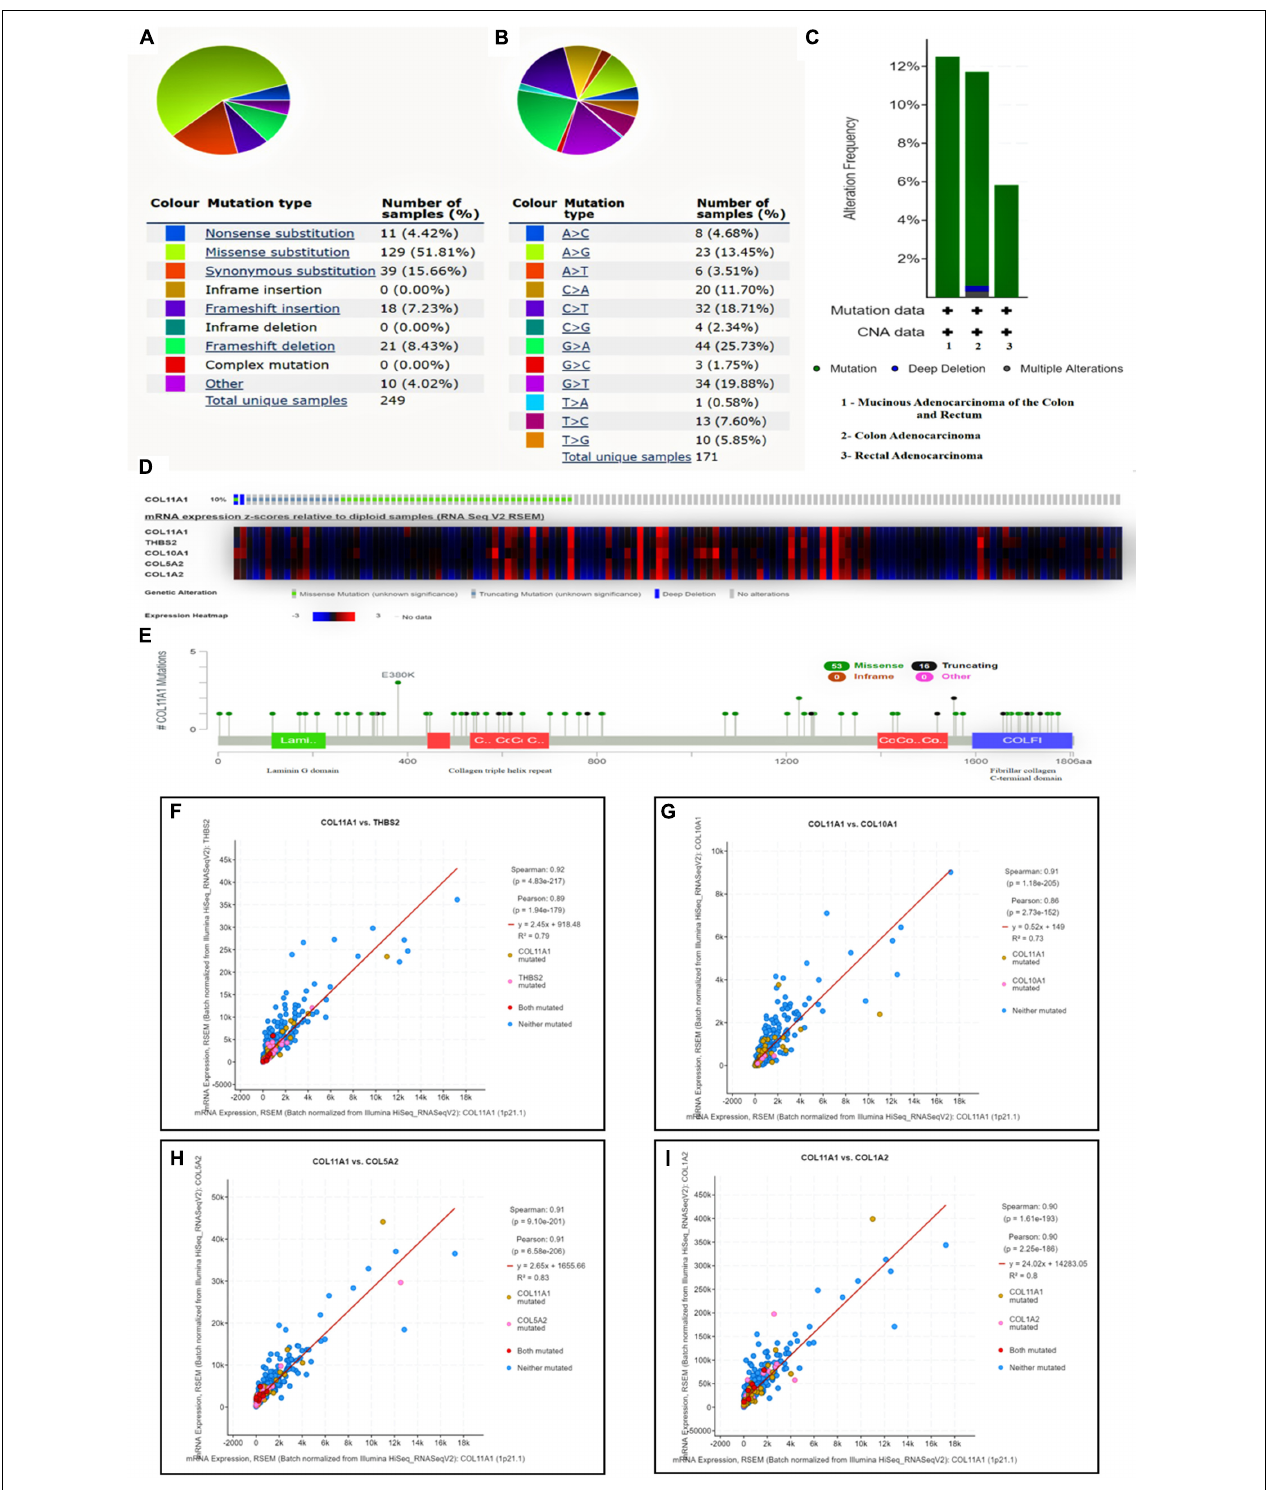
FIGURE 5 | Mutational analysis of COL11A1 gene. (A) Summary of various types of mutations associated with COL11A1 gene. (B) Bar-graph depicting various types of substitutional mutation occurring within the gene. (C) Mutation along the subtype of cancer including mucinous adenocarcinoma of colon and rectum ( > 12%), colon adenocarcinoma ( < 12%), and rectal adenocarcinoma ( ∼ 6%). (D) Oncoprint showing mutational rate of COL11A1 gene and the heatmap for mRNA expression of associated genes. (E) Genomic information of COL11A1 mutation. (F–I) Graphical representation of correlation between COL11A1 gene showing mutation, Pearson correlation coefficient, Spearman correlation coefficient and regression line with, (F) THBS2, (G) COL11A1, (H) COL5A2, (I) COL1A2.